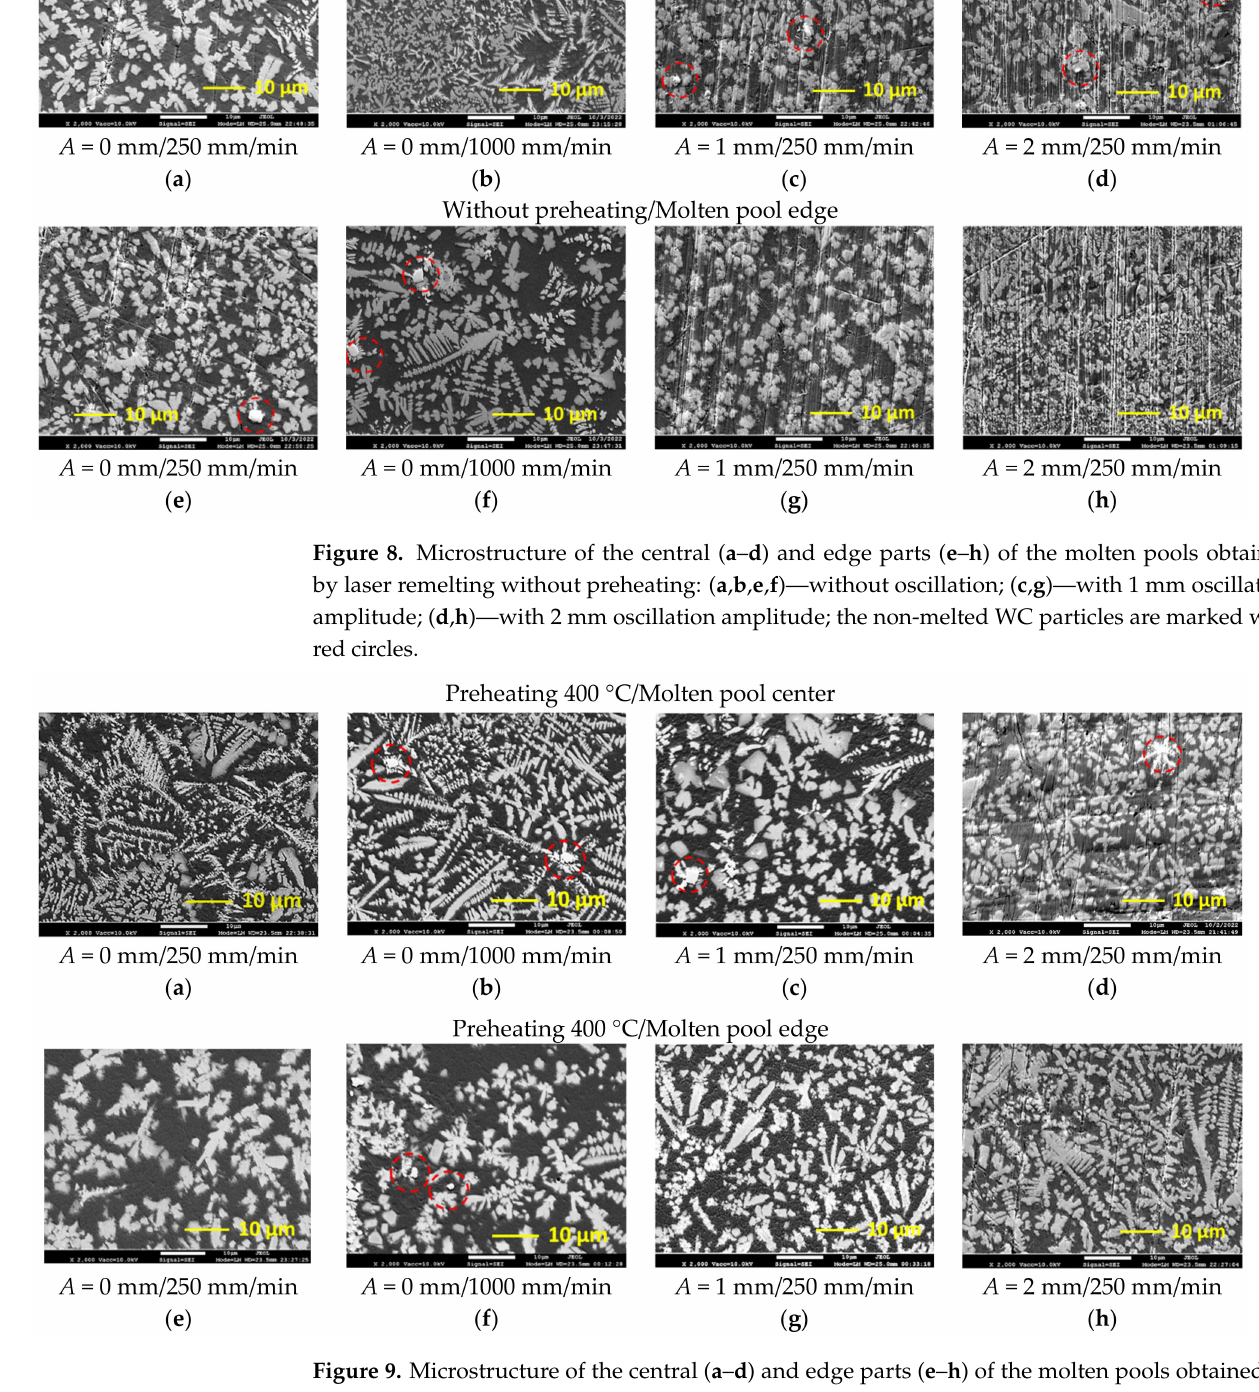
Figure 9. Microstructure of the central ( a – d ) and edge parts ( e – h ) of the molten pools obtained by laser remelting with pre-heating at 400 ◦ C: ( a , b , e , f )—without oscillation; ( c , g )—with 1 mm oscillation amplitude; ( d , h )—with 2 mm oscillation amplitude; the non-melted WC particles are marked with red circles. Figure 8a,e show the fine equiaxed dendritic microstructure of solidified molten pool obtained at 250 mm/min laser speed providing the highest heat input. At the longer heating and lower cooling rate, provided by a laser speed of 250 mm/min, a very